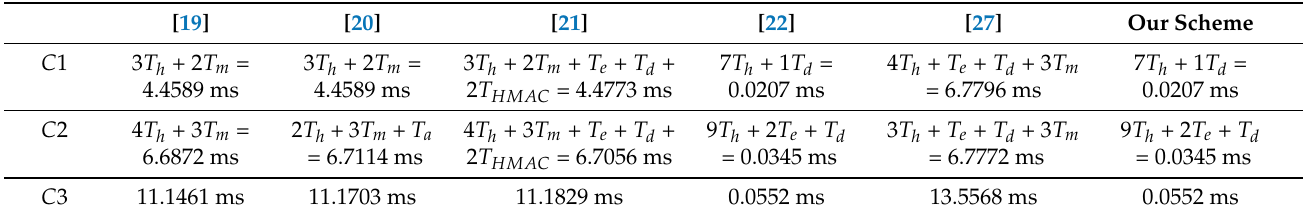
Table 4. Computation cost comparison table.